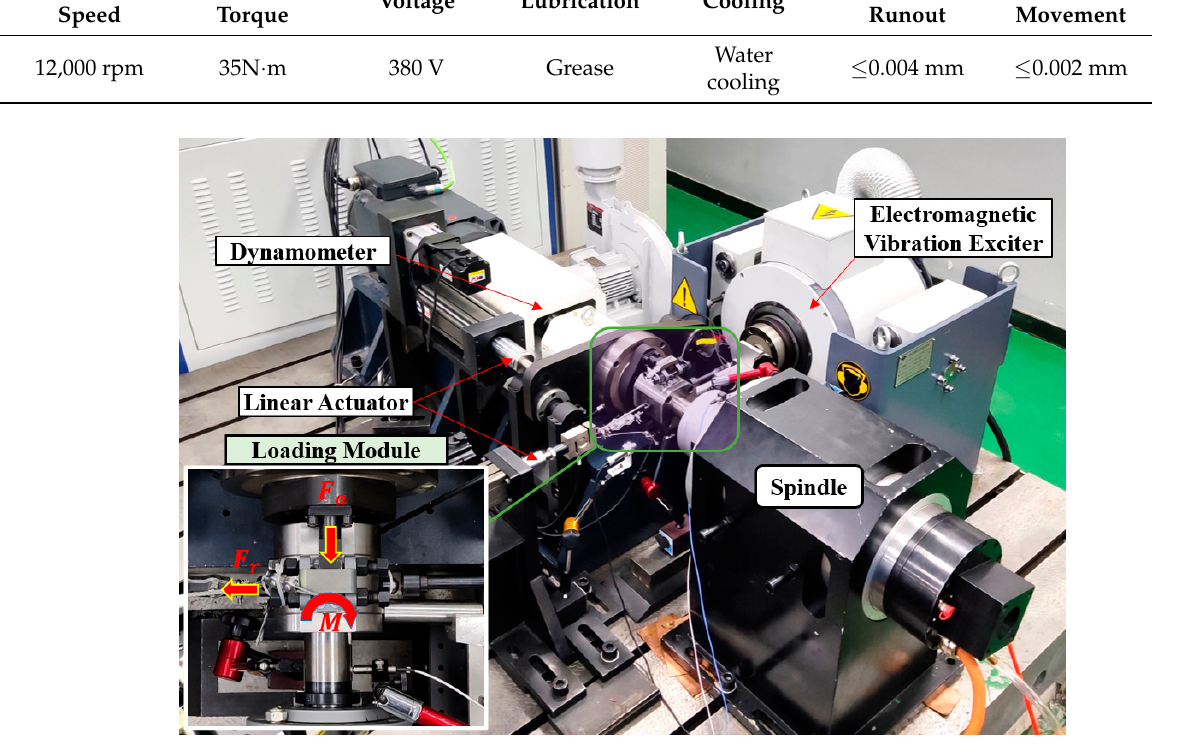
Figure 16. Spindle reliability test bed.